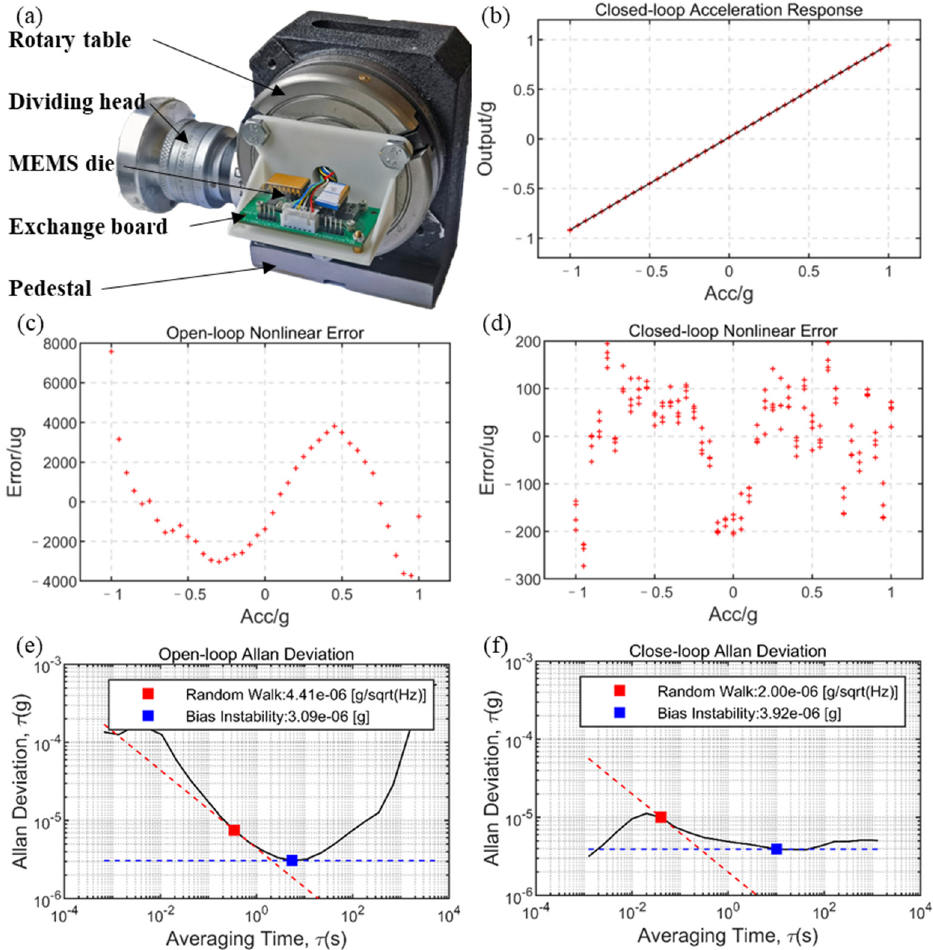
Figure 9. Test conditions: ( a ) test platform, ( b ) closed-loop acceleration response, ( c ) non-linear error of open-loop test, ( d ) non-linear error of closed-loop test, ( e ) Allen variance of open-loop test, and ( f ) Allen variance of closed-loop test.